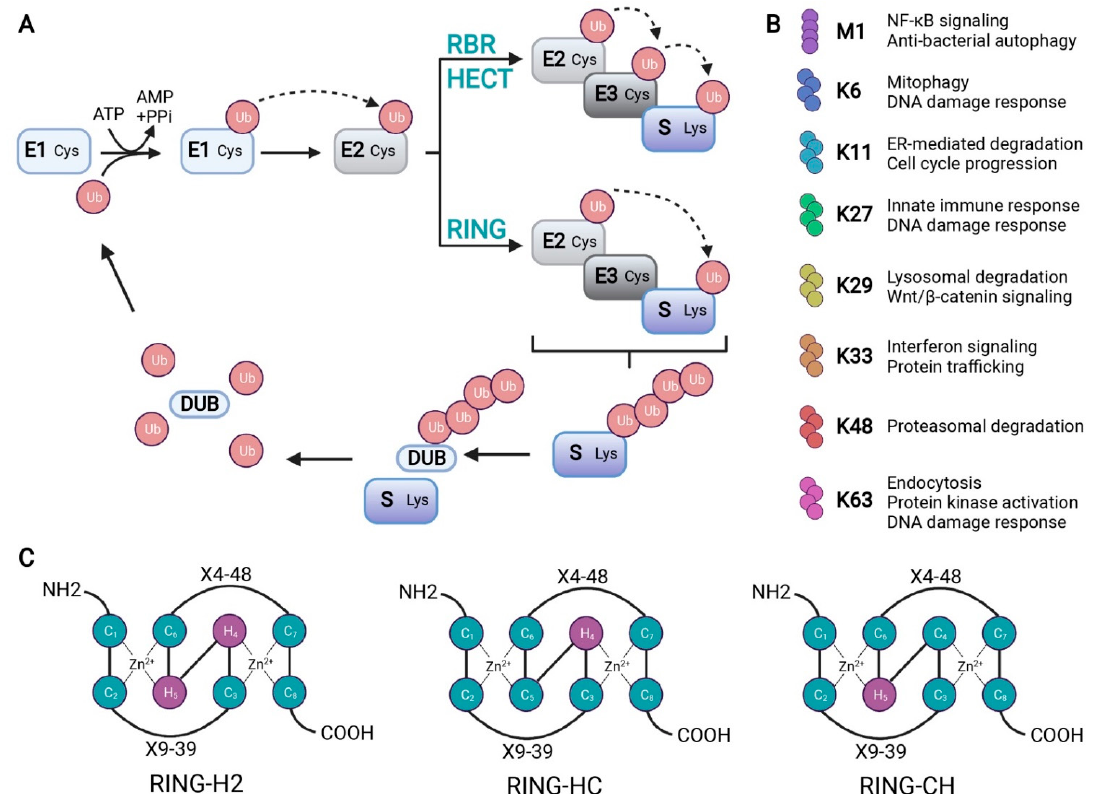
Figure 1. Schematic representation of the ubiquitination process. ( A ) Ubiquitination starts with an